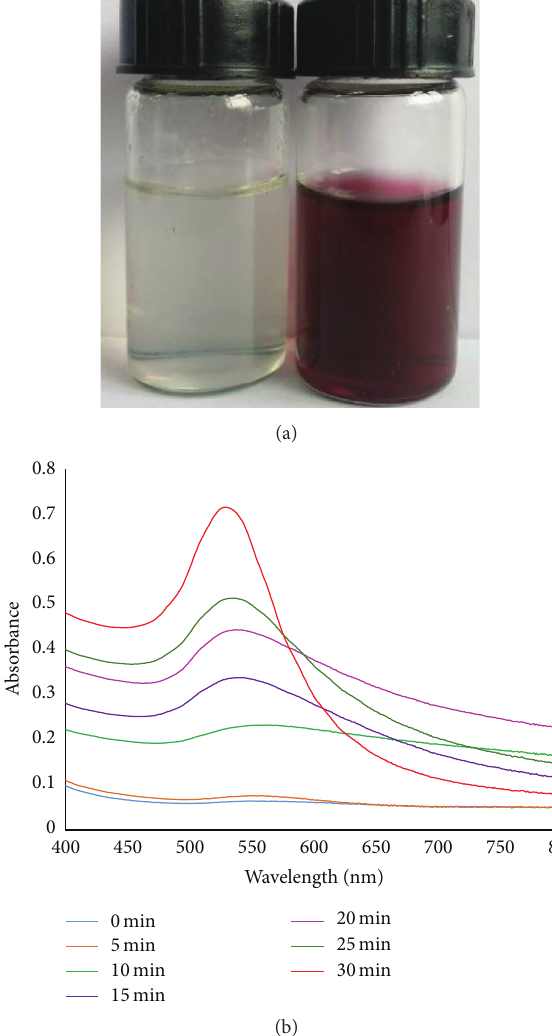
Figure 1: (a) Cell-free filtrate of B. niabensis 45 (left) and biosyn- thesized GNPs using cell-free filtrate of B. niabensis 45 (right). (b) UV-vis spectra of GNPs at different reaction time